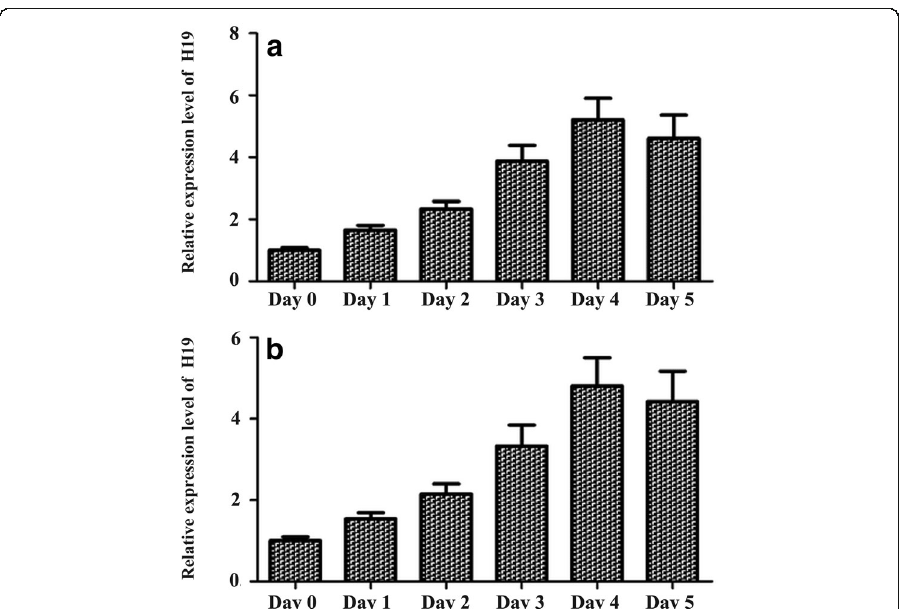
Fig. 2 Expression levels of H19 during differentiation of bovine tibia skeletal muscle (sk-muscle) satellite cells ( a ) and C 2 C 12 myoblast cells ( b